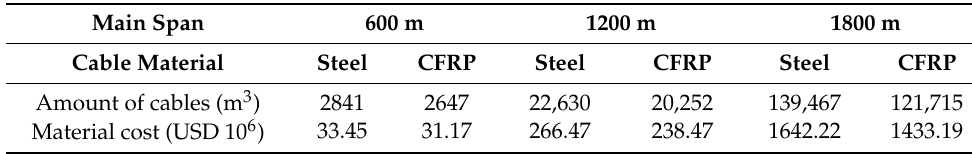
Table 4. Amount and cost of steel used for pylons.